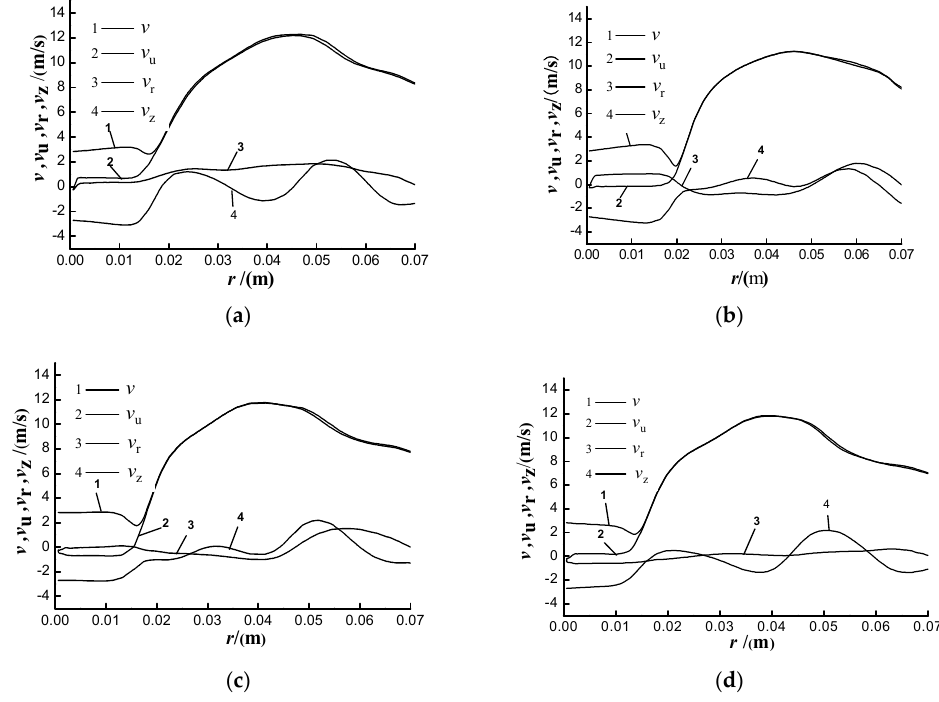
Figure 10. Velocity variable curves for the axial cross-section Z = 12.5 mm along the radial direction. ( a ) 0°; ( b ) 90°; ( c ) 180°; ( d ) 270°.